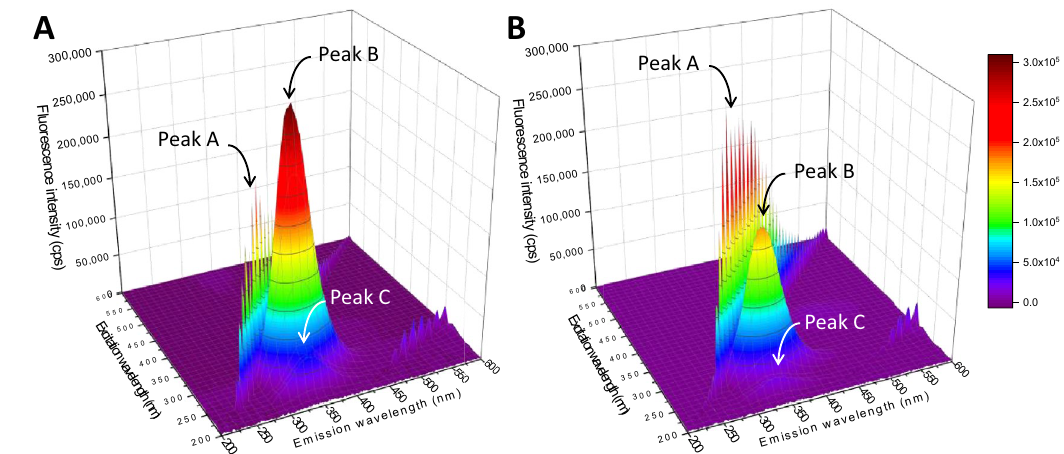
Figure 6. 3D fluorescence spectra of BSA (4 µM) in the ( A ) absence and ( B ) presence of 5A8HQ (5 µM) at 310